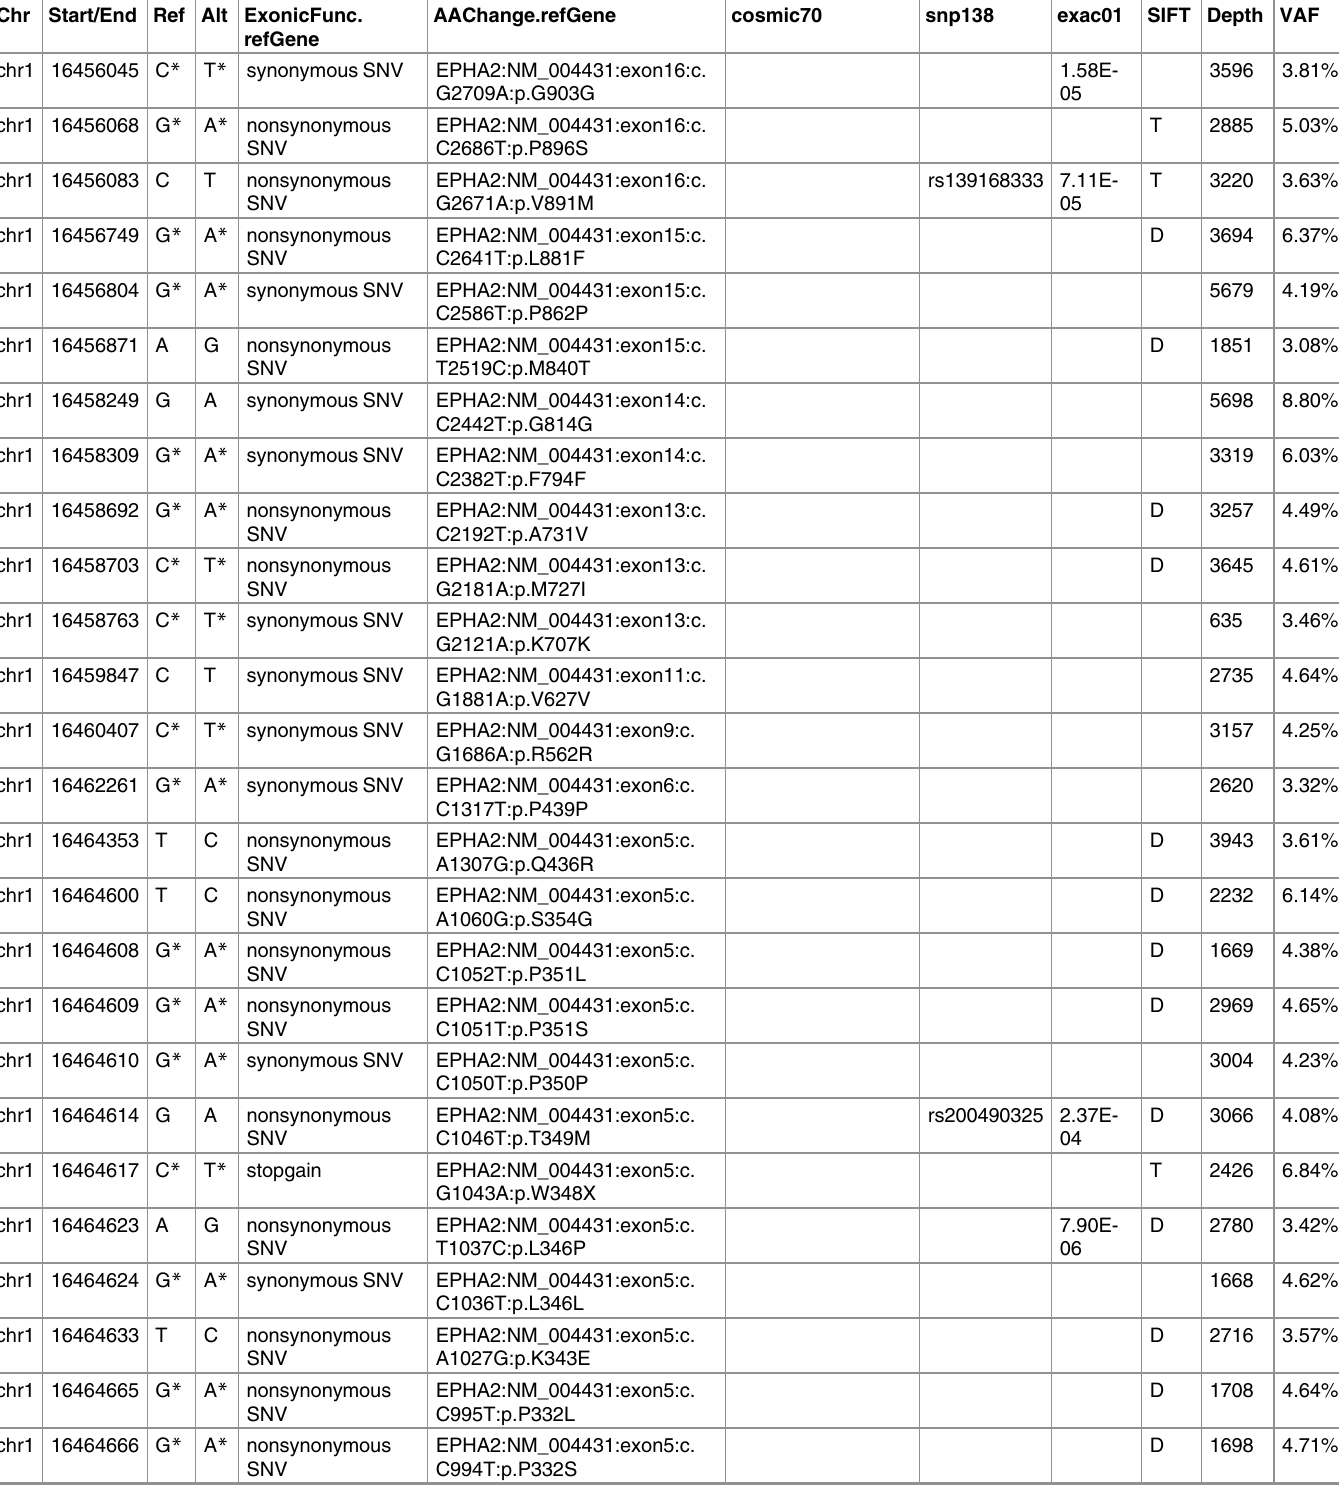
Table 4. Somatic EPHA2 coding SNVs found in the paired cataract lens panel (VAF > 3%). Chr Start/End Ref Alt ExonicFunc.